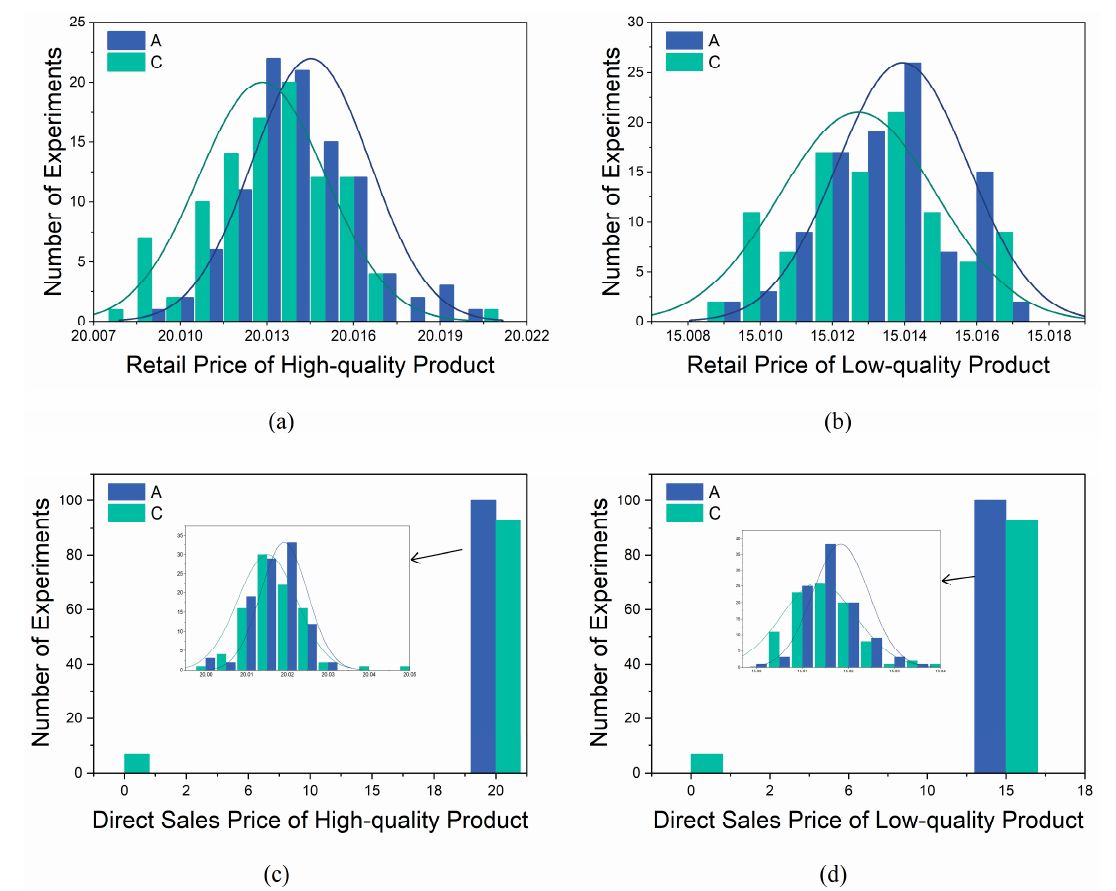
Figure 9. Prices in A and C of: ( a ) high-quality product in retail channel; ( b ) low-quality product in retail channel; ( c ) high-quality product in direct sales channel; ( d ) low-quality product in direct sales channel. ( t = 100).